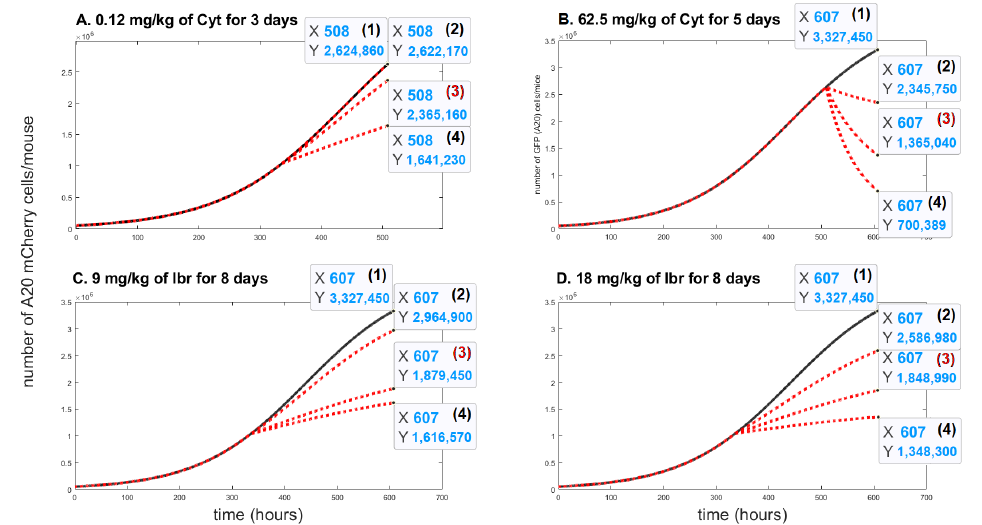
Figure 4. The time evolution of A20 mCherry cells without any treatment ( black solid lines) and with different values of the death rate resulting from the action of the drug, µ AC ( red doted lines). Three values were considered for each treatment protocol: In Figure 4A (2) µ AC = 0.0001; (3) µ AC = 0.001;